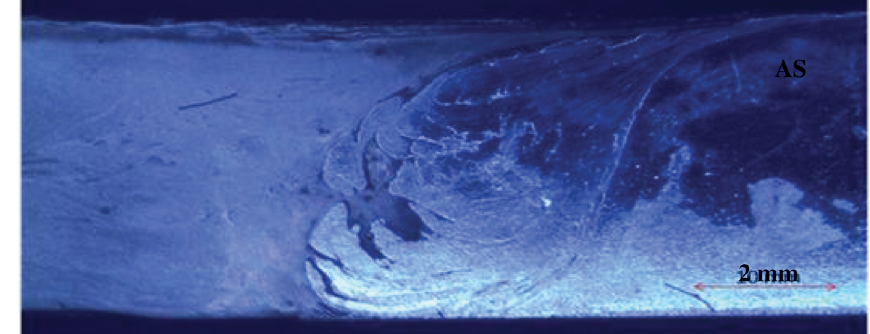
Figure 2: Optical micrograph of cross-section sample, at 305 rev min − 1 and 50 mm min − 1 welding speed. Arrow coming out of page is the welding direction.